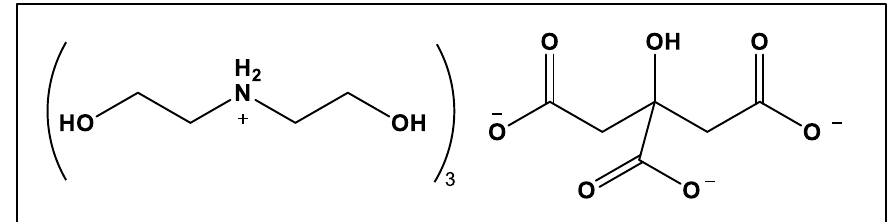
Figure 15. Structure of tri-[bis(2-hydroxyethylammonium)]citrate (DCi). Three sliding velocities (0.10, 0.15 and 0.20 m/s) were used to compare the lubricating performance of MO with respect to MO mixed with 1 wt% or 2 wt% DCi. The friction coefficient and wear volume were reduced for each sliding velocity, prevalently at 0.15 m/s and a MO + 2% DCi solution with which friction and wear decreases of 16% and 40%, respectively, were observed (Figure 16).